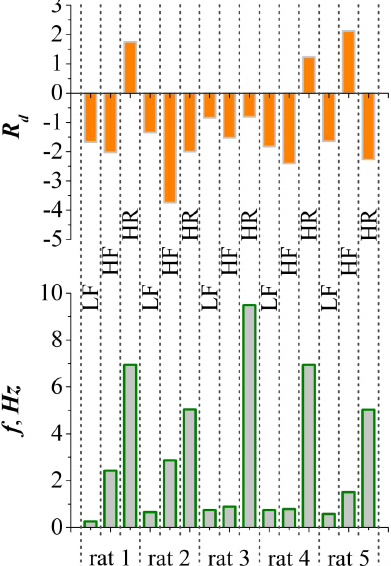
Fig. 6. Results of optimization of the objective function R d .